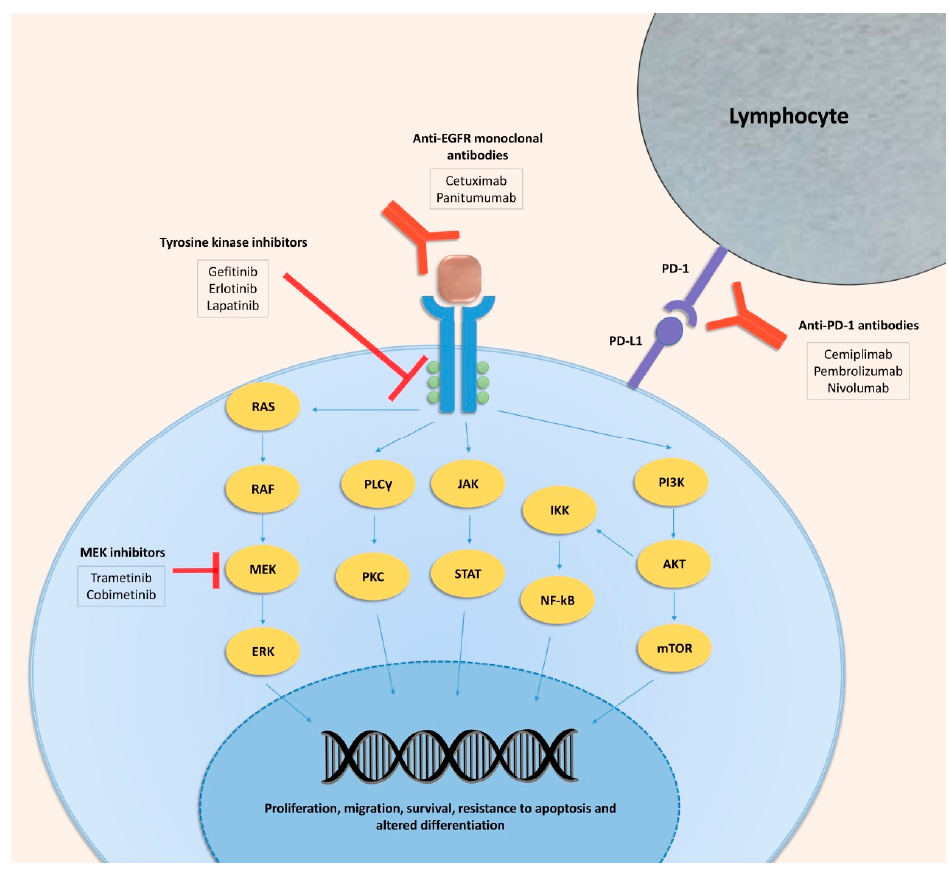
Figure 1. Therapeutic landscape of cutaneous squamous cell carcinoma.